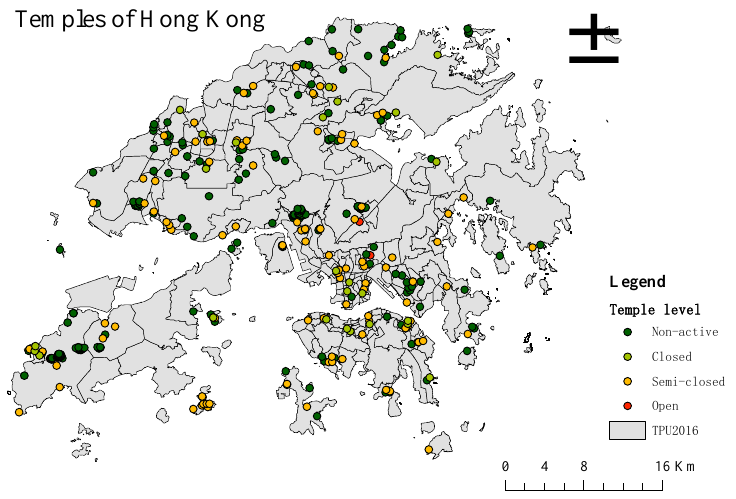
Figure 4. Four Types of Temples after Classification (Base on TPUs of 2016).